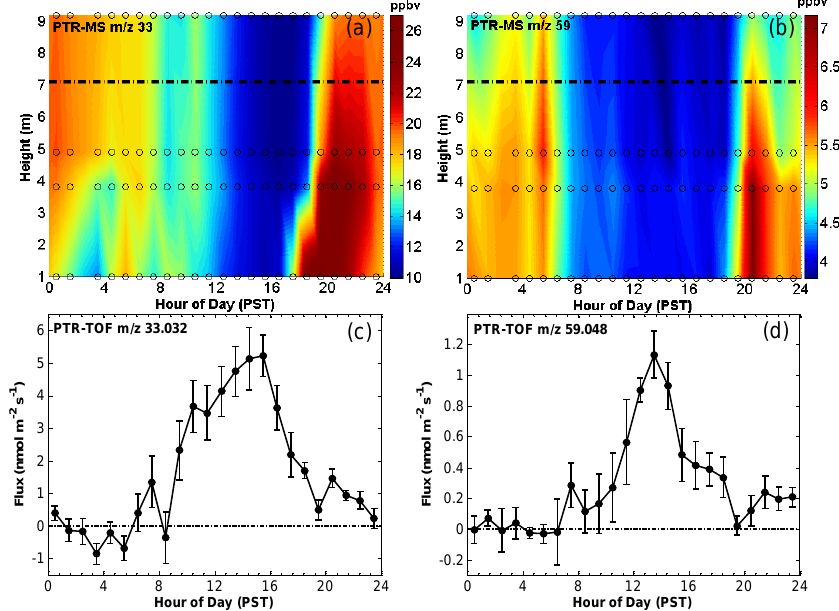
Fig. 8. Mean vertical gradient (a and b, PTR-MS) and flux (c and d, PTR-TOF-MS) diurnal patterns of methanol and acetone respectively. Interpolated gradient measurements (a and b) are color coded with actual measurement timing and vertical positions shown as open circles, and flux measurement height shown as a broken black line. Flux diurnal patterns of methanol and acetone shown in (c) and (d) agree well with observed vertical gradients during day and night. Error bars in (c) and (d) denote the standard errors of all measurements at the respective hour of the day.